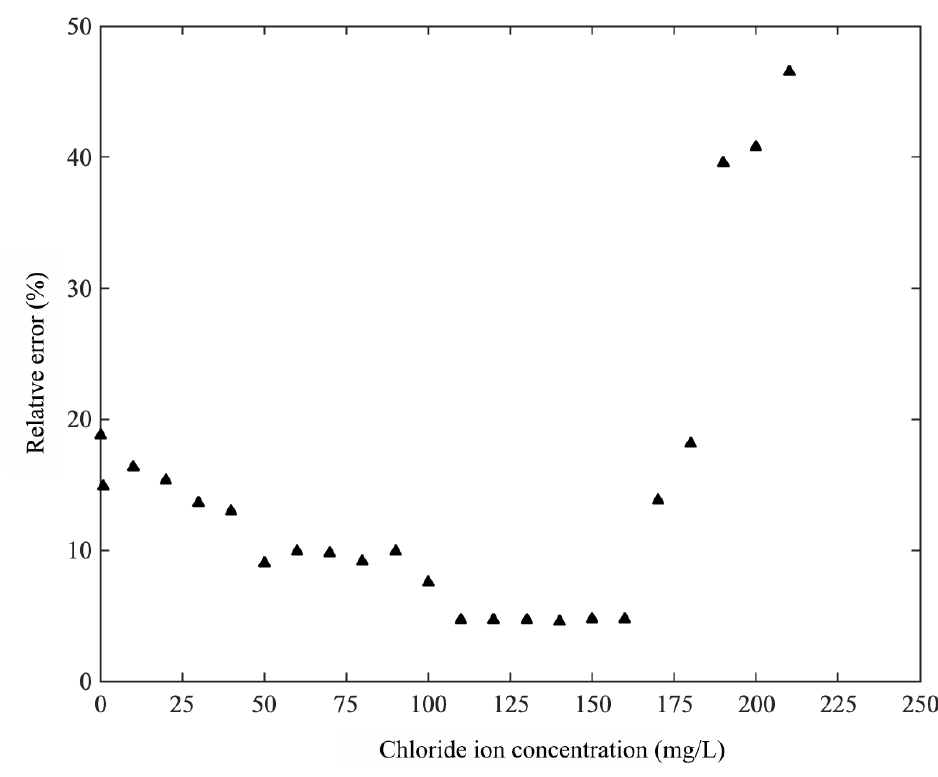
Figure 3. Fitting results of chloride ion and resistivity in soil using different functions.